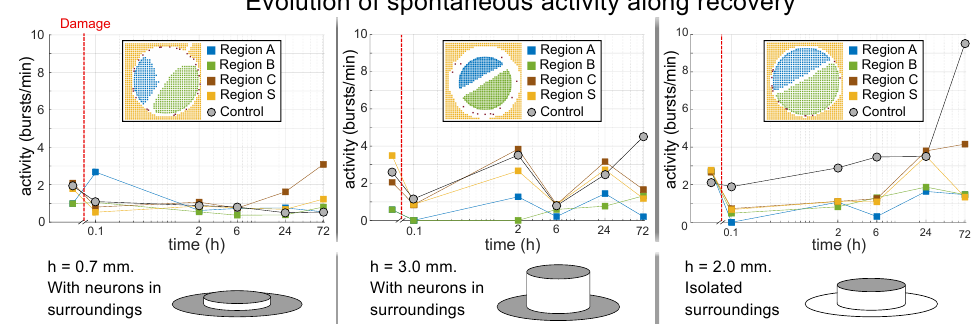
Figure 5. Activity alterations upon damage in homogeneous cultures. The top plots show the evolution of average spontaneous activity (in a quasi-logarithmic scale) for three representative scenarios with varying height h of the PDMS disc. The vertical red dashed line marks the time of damage. The bottom sketches provide a visual aid of the experimental preparations, highlighting the presence (gray) or absence (white) of surrounding neurons. The activity is plotted individually for each spatial region monitored (half cultures ‘A’ and ‘B’, contour ‘C’ and surroundings ‘S’). Measurements in a control culture are included as